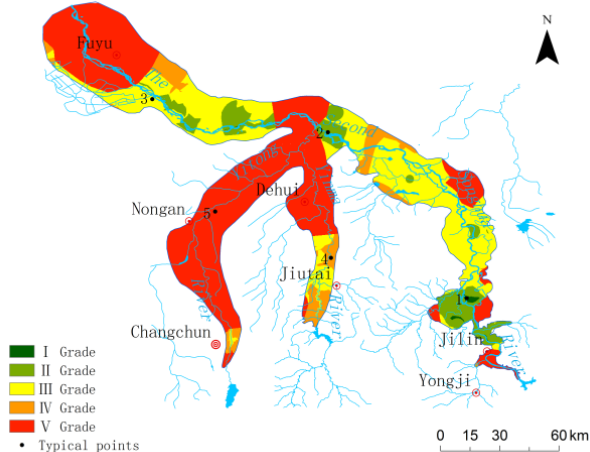
Figure 21. Overall suitability of locations within the core study area for RBF works. Table 12. All single index values and scores for five typical points.